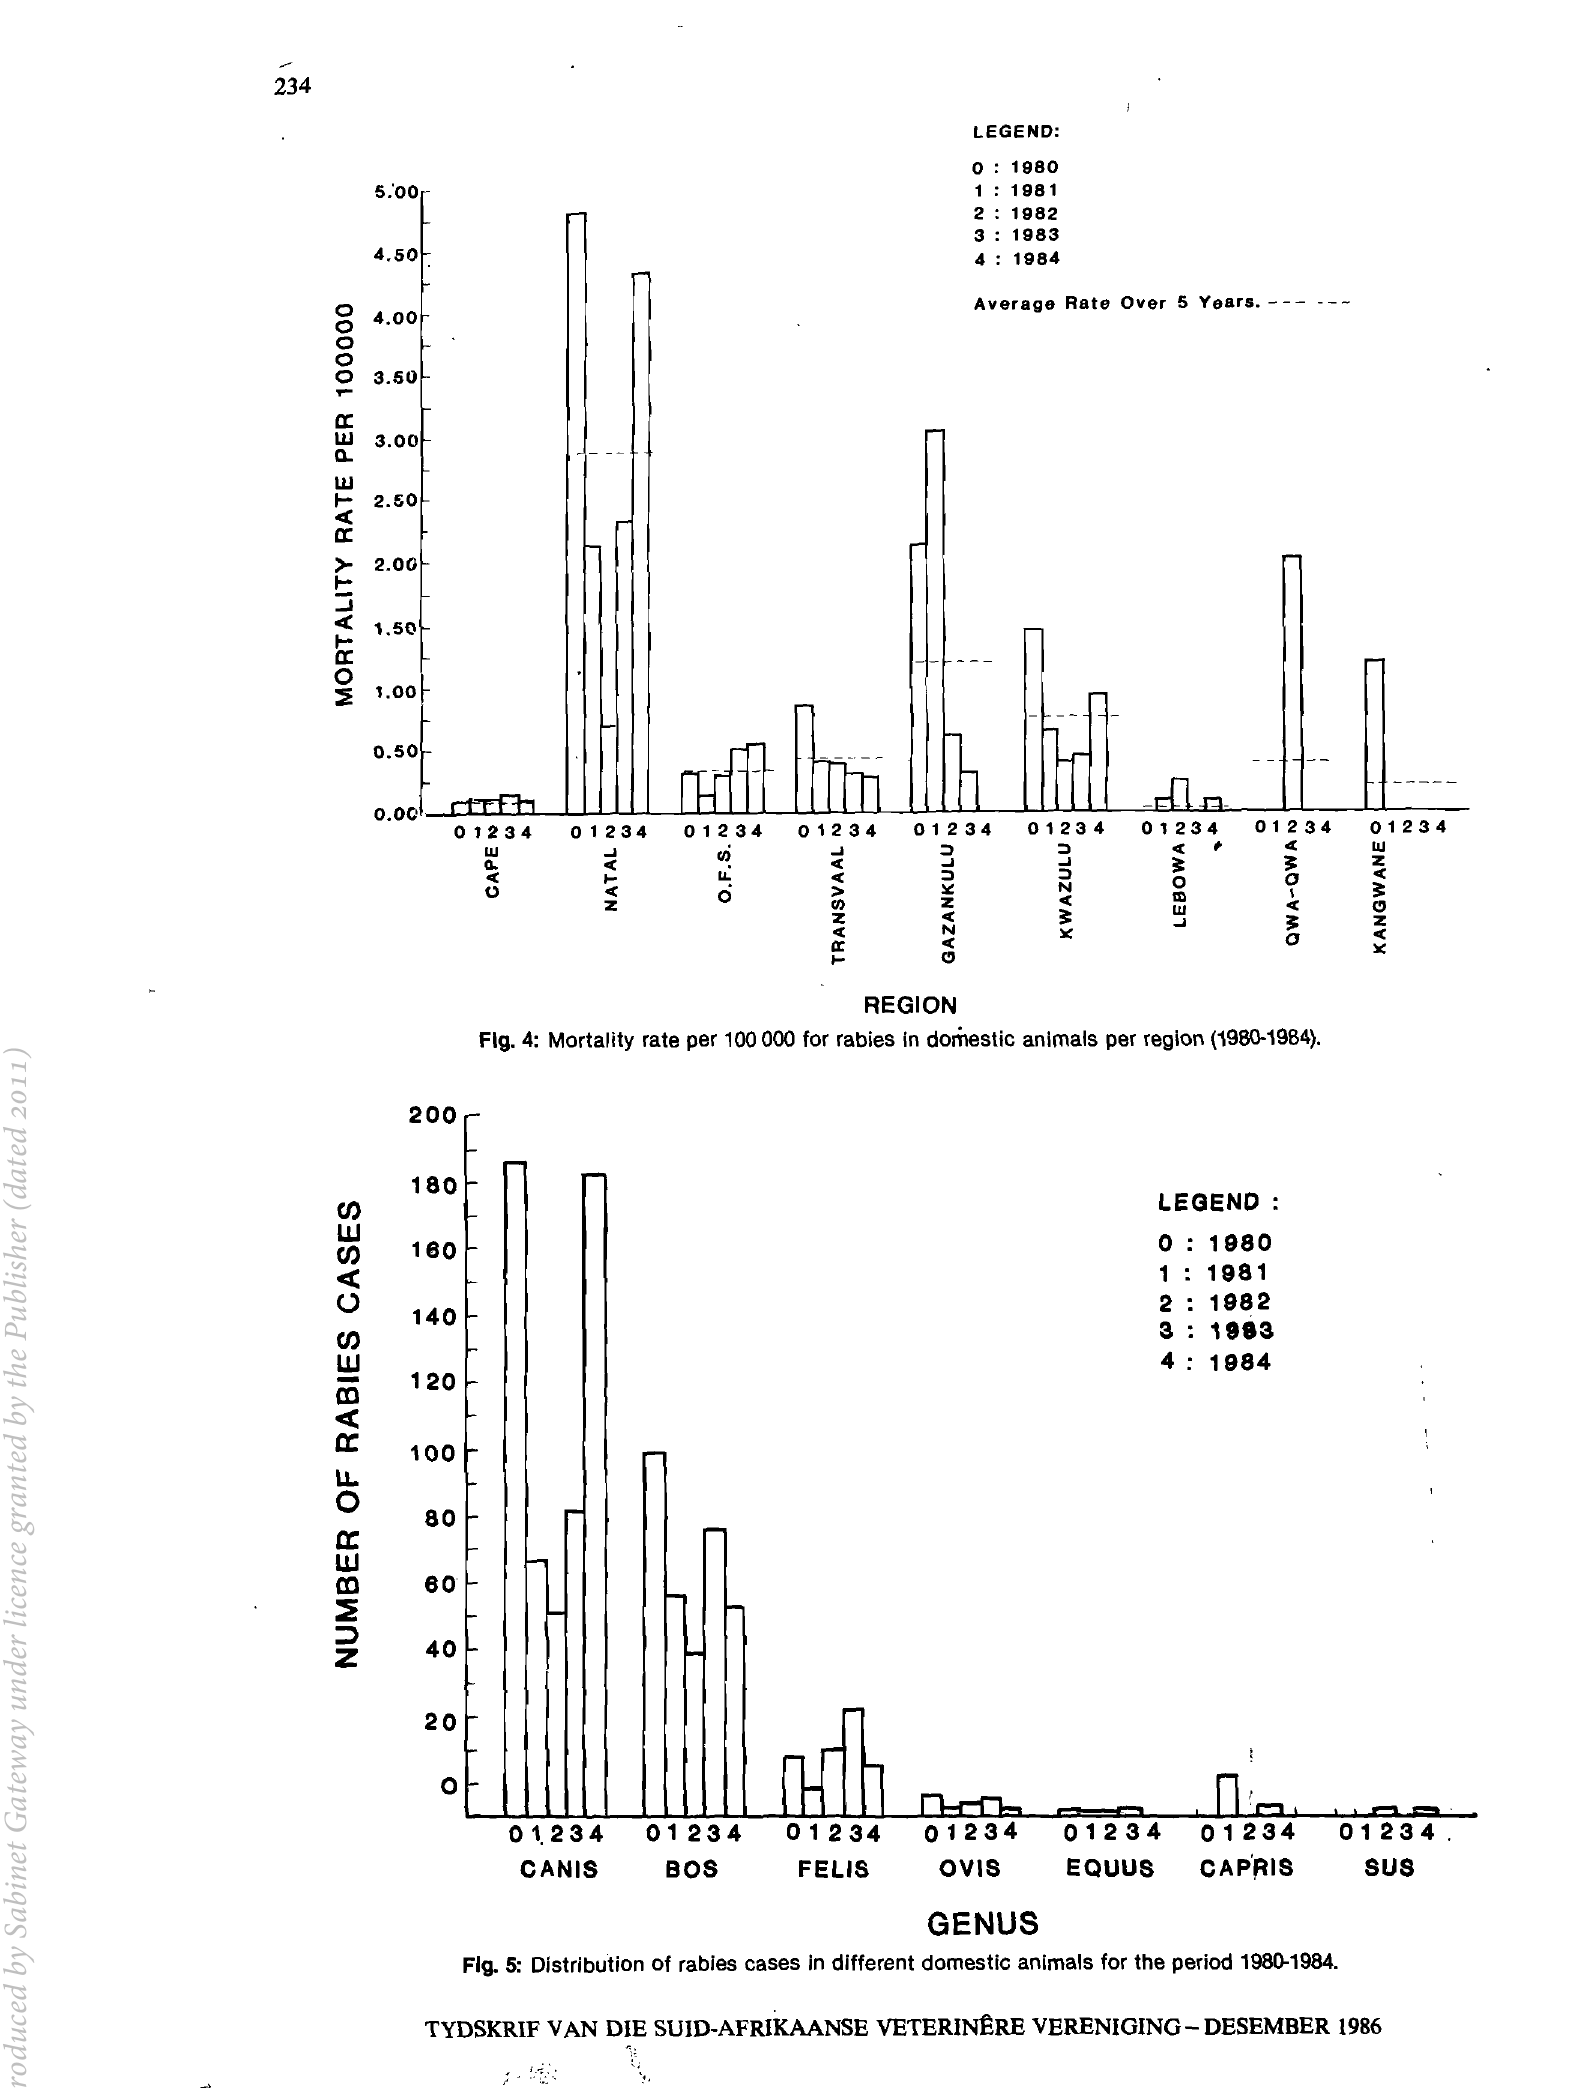
Fig. 5: Distribution of rabies cases in different domestic animals for the period